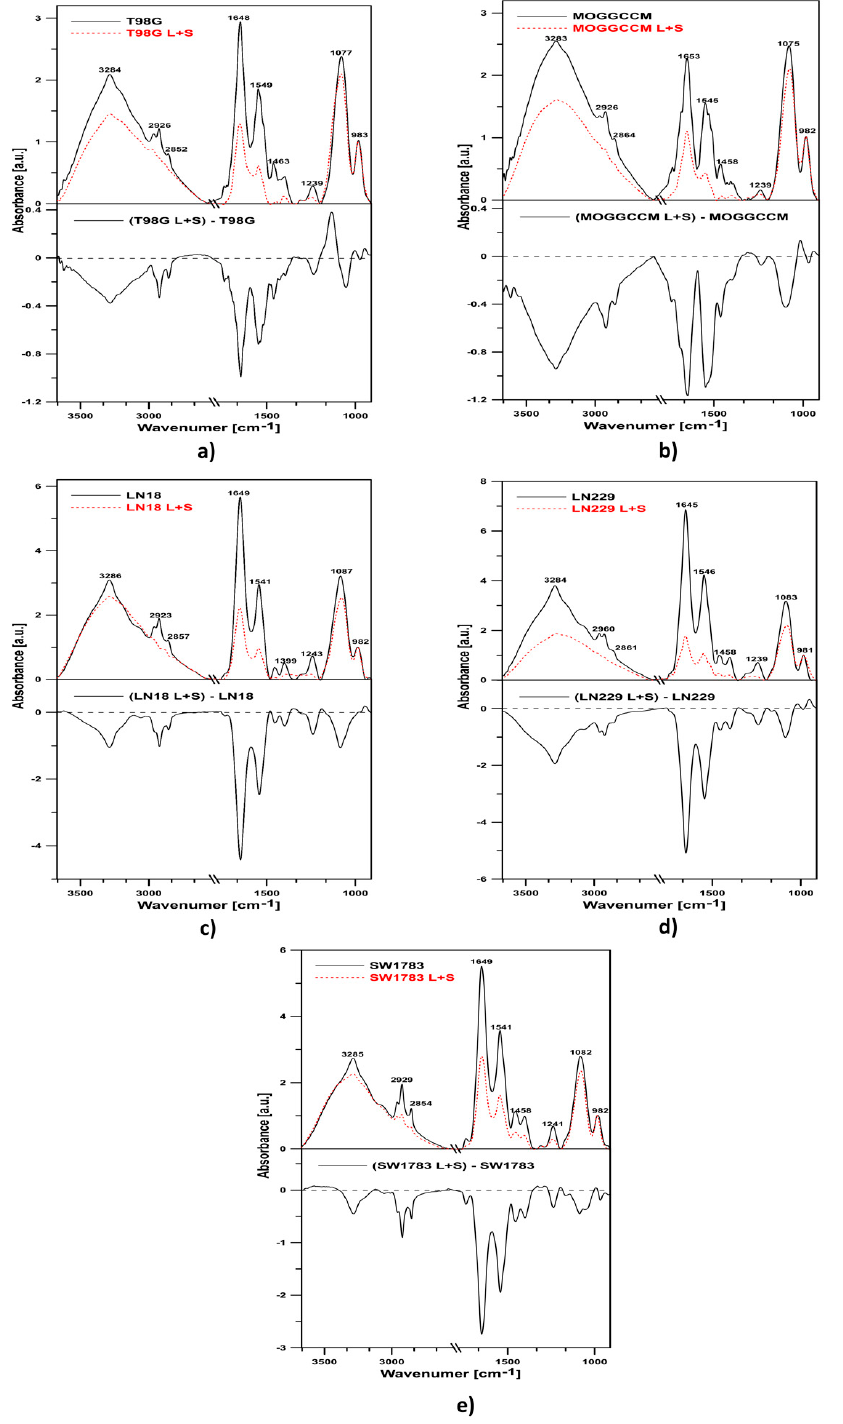
Figure 11. ATR-FTIR spectra of the MOGGCCM ( a ), T98G ( b ), LN229 ( c ), LN-18 ( d ), and SW1783 cells ( e ). The top panels of the graphs show spectra of the control cells (black solid line) and cells treated with a combination of lensoside A β and sorafenib (red dashed line) for 24 h. The lower panels present differential spectra of the cells.